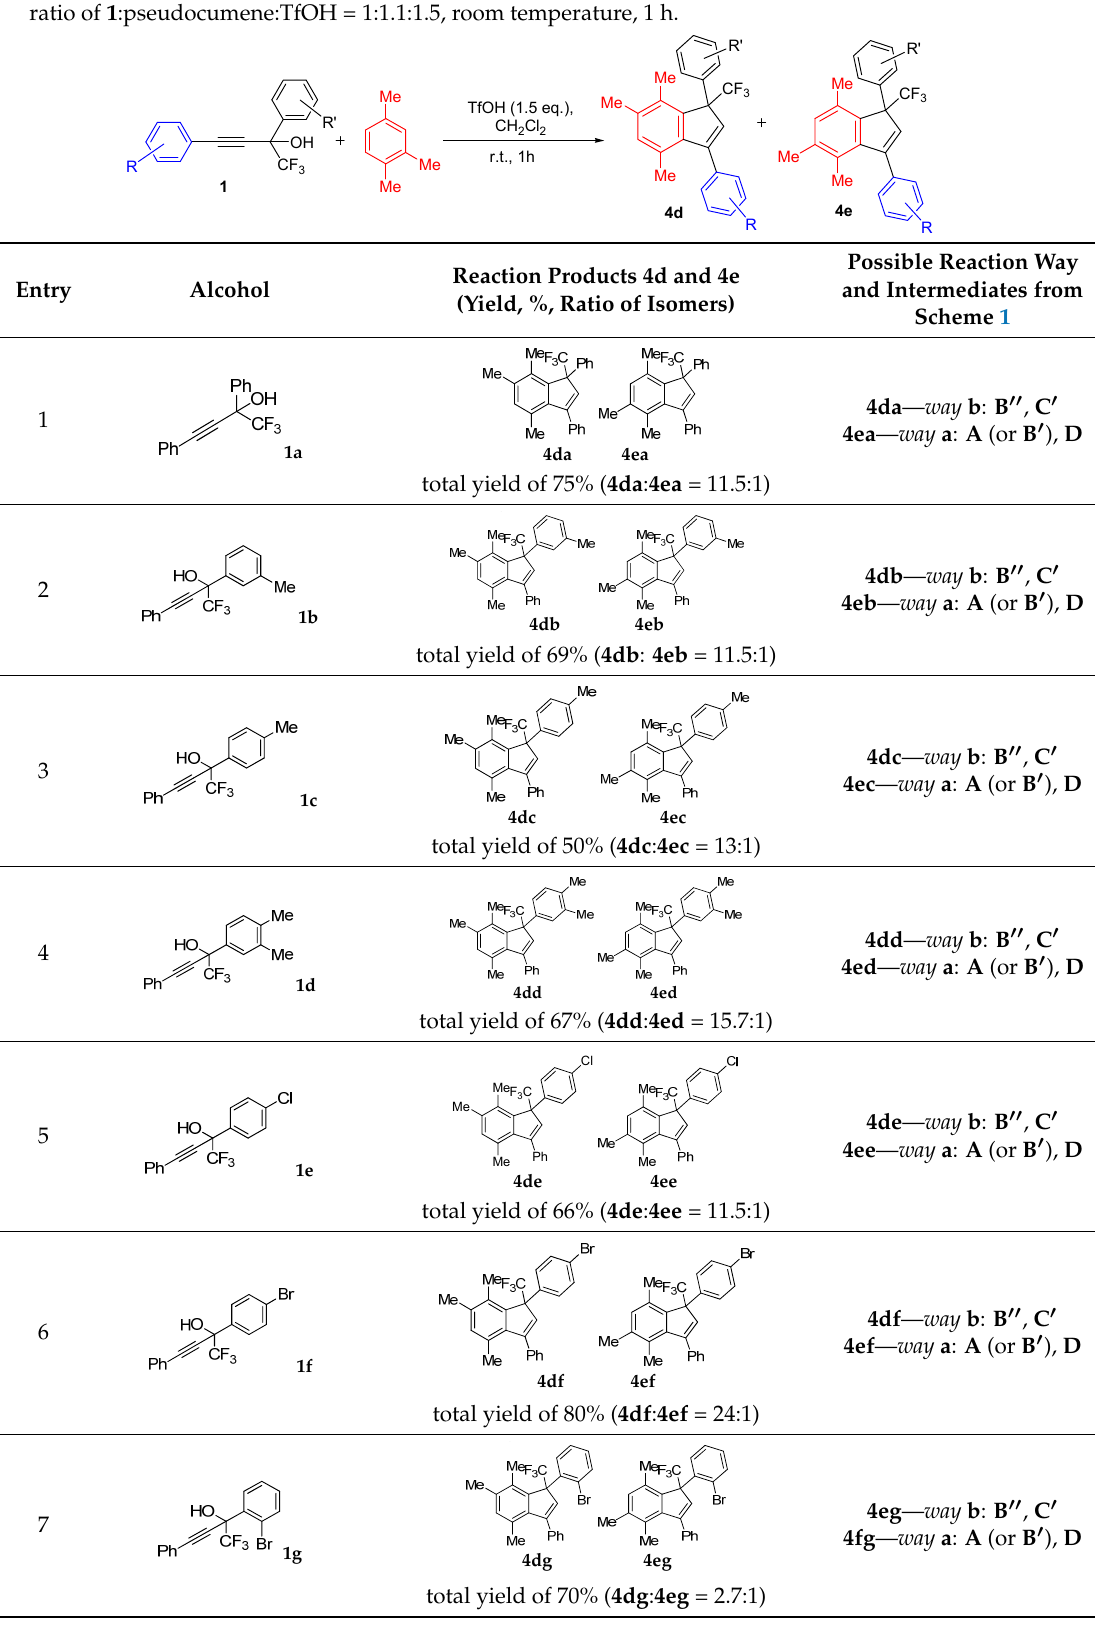
Table 6. TfOH-promoted reaction of 1 with pseudocumene; reaction conditions: TfOH, CH 2 Cl 2 , molar ratio of 1 :pseudocumene:TfOH = 1:1.1:1.5, room temperature, 1